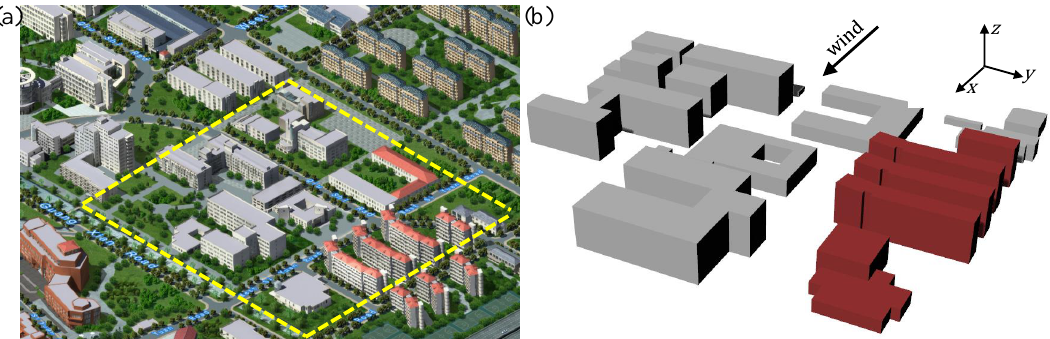
Figure 1. ( a ) Map of the site of the buildings. ( b ) three-dimensional model of the buildings.